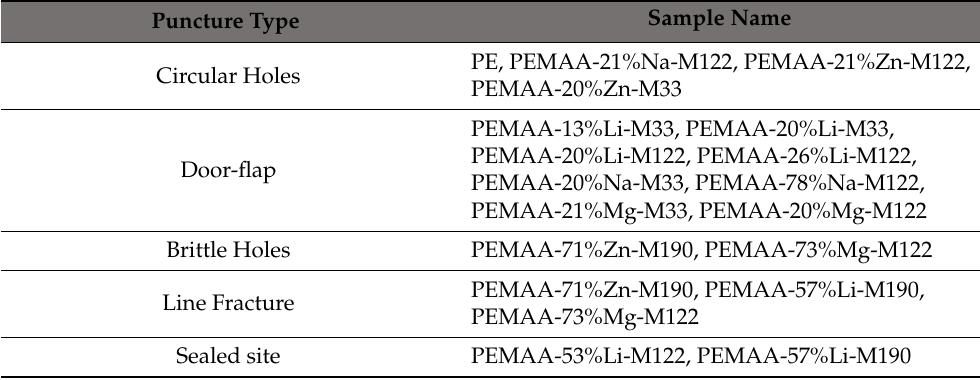
Figure 14. ( a ) Sealed exit site from a PEMAA-53%Li-M122 sample ( b ) Sealed entry site from a PEMAA-58%Li-M190 sample, and ( c ) Line fracture from a PEMAA-58%Li-M190 sample. Table 4. The responses of PEMAA samples to the high-impact